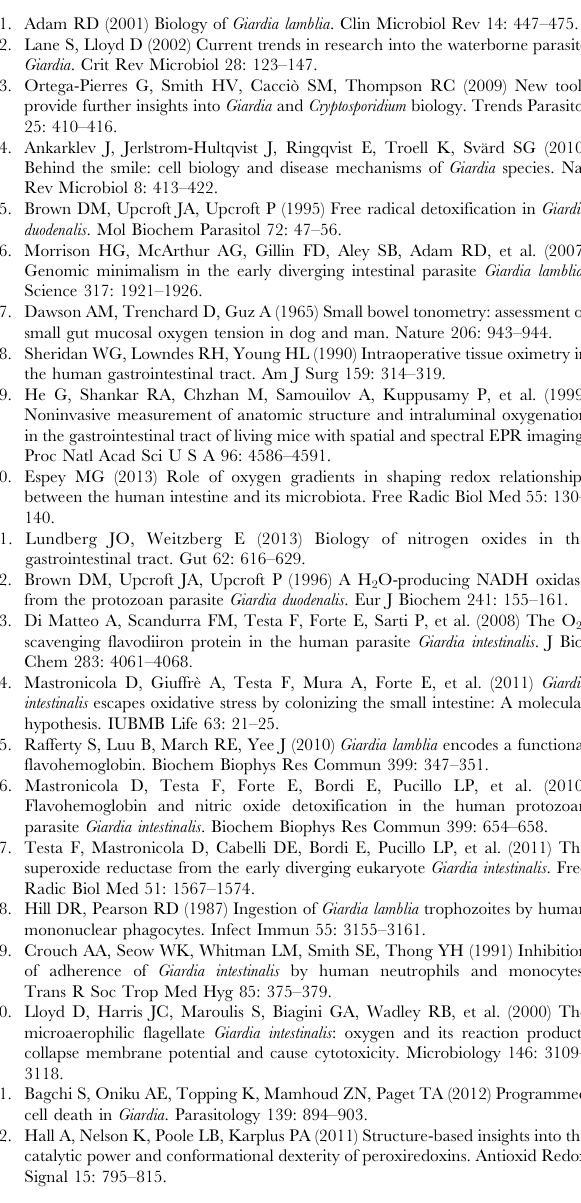
Figure S3 4–12% SDS-PAGE analysis. Lane 1: molecular mass marker (Invitrogen). Lanes: 2–4: 0.4, 0,7 and 1.5 m g His-tagged purified Gi Prx1a. Figure S4 Reaction of free cysteine with ONOO 2 . A) Absorption changes measured at 310 nm after anaerobically mixing in the stopped-flow apparatus a solution of ONOO 2 with degassed buffer alone (dashed line) or containing free cysteine